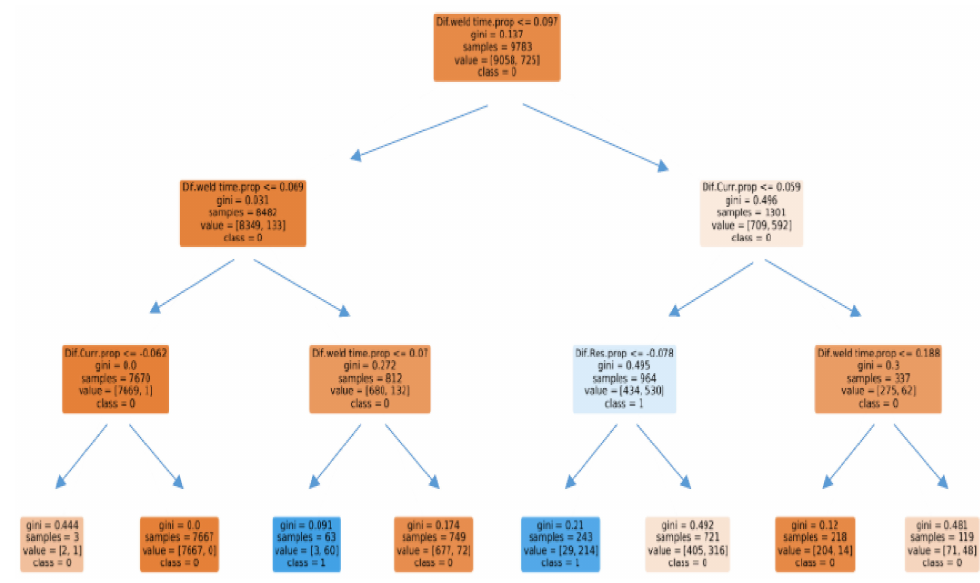
Figure 10. Decision tree example for the parameters of welding process problems.